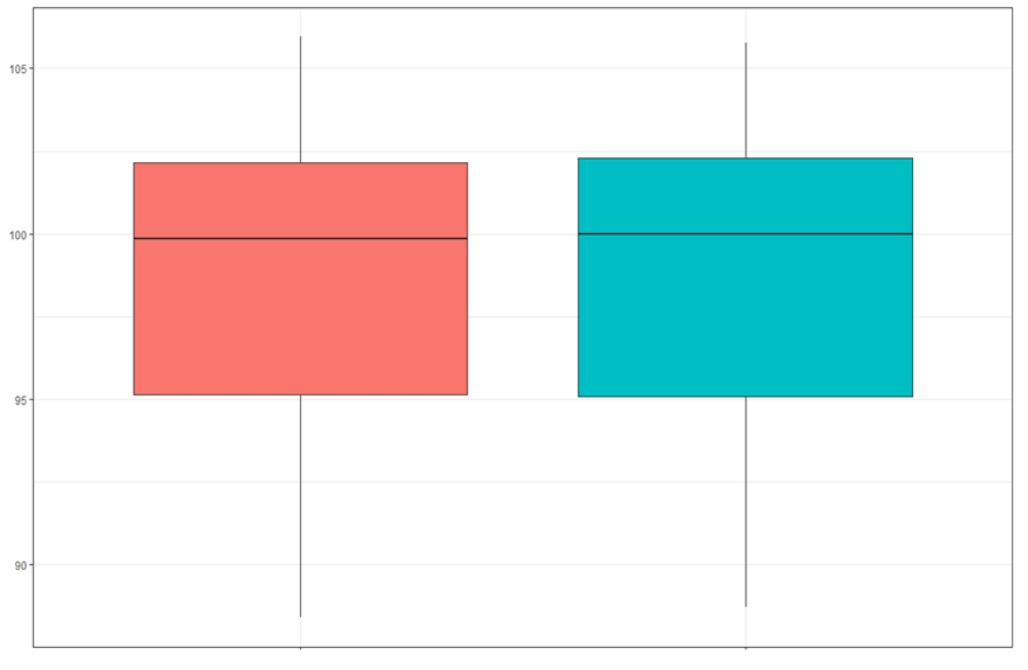
Figure 4. Boxplot of the distribution of the maxillary size data with respect to the mandible in the intraoral frontal photograph and in the study model. The red bloxplot is the results of the photography group, and the green bloxplot is the one for the model group.